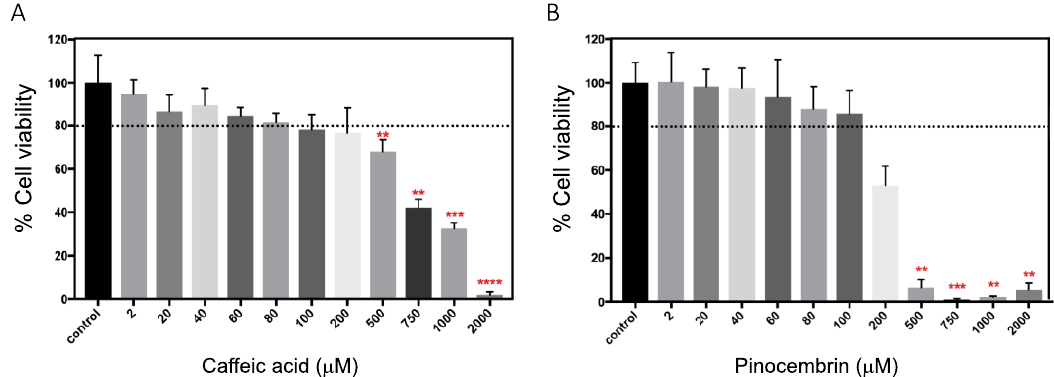
Figure 8. Viability of HUVECs treated with polyphenols. Cells were exposed to different concentrations of polyphenols for 24 h and cellular viability was measured by tetrazolium salt (MTS) assay. ( A ) Cells treated with 2–2000 mM of caffeic acid, and ( B ) Cells treated with 2–2000 mM of pinocembrin. Unexposed cells to nPSi-βCD microparticles were used as a control. The dashed line indicates the cell viability of 80%. All results are presented as the mean ± standard deviation (SD). The experimental data from all relevant studies were analyzed using Analysis of Variance (ANOVA) and Kruskal–Wallis test, which indicate the statistical significance when the percentage of cells viability exposed to the different microparticle concentrations are different from the control. ** p < 0.01, *** p < 0.001, **** p < 0.0001, (n = 3).